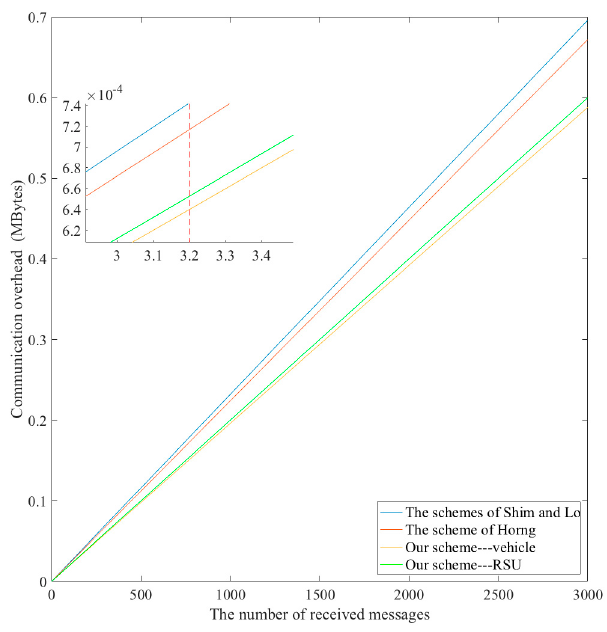
Figure 9. Comparison of the communication overhead.